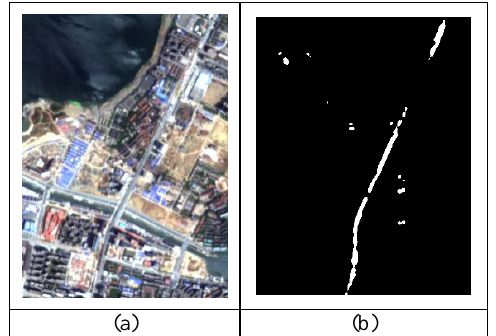
Figure 10. An example of road extraction result (a) original image; (b) extraction result